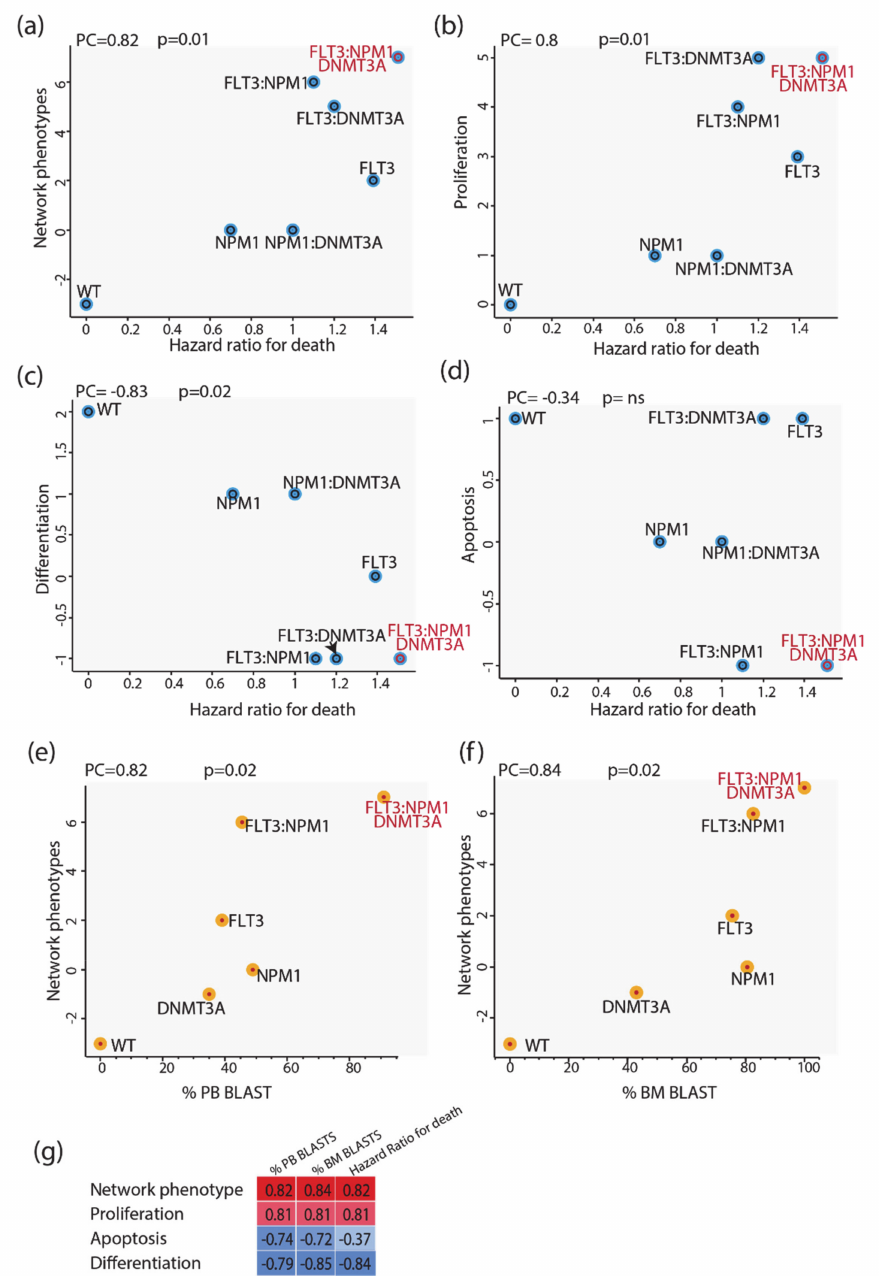
Figure 6. Predictive power of Boolean models. Scatterplot comparing the mutation-specific hazard ratios with the predictions of our models, as revealed by the network-score ( a ) and integrated network phenotypes-score ( b – d ). Scatterplot comparing the mutation-specific peripheral blood (PB) and bone marrow (BM) blast percentages with the integrated network phenotypes-score ( e – f ). ( g ) Heatmap showing the Pearson Correlation (PC) between clinical features (columns) and network phenotype scores